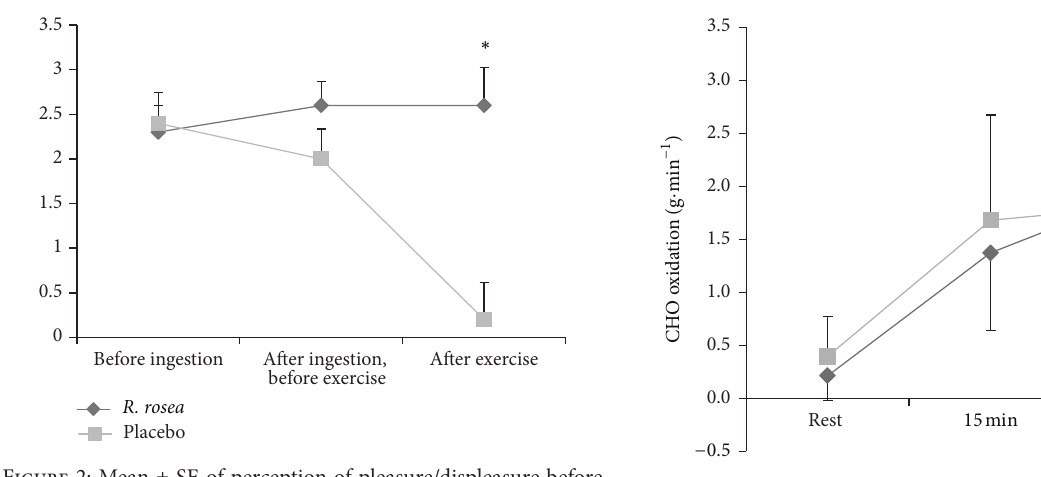
Figure 2: Mean ± SE of perception of pleasure/displeasure before ingestion, after ingestion but before exercise, and after exercise between R. rosea and placebo conditions ( ∗ 𝑃 = 0.003 ).